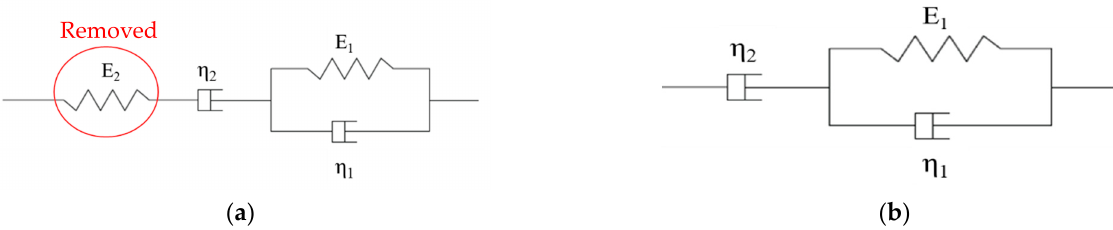
Figure 3. Rheological models: ( a ) Burgers model; ( b ) three-element model.